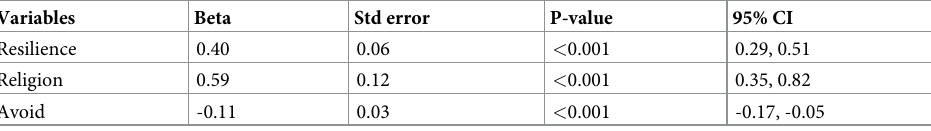
Table 3. Multivariate robust regression model for life satisfaction, resilience, and coping